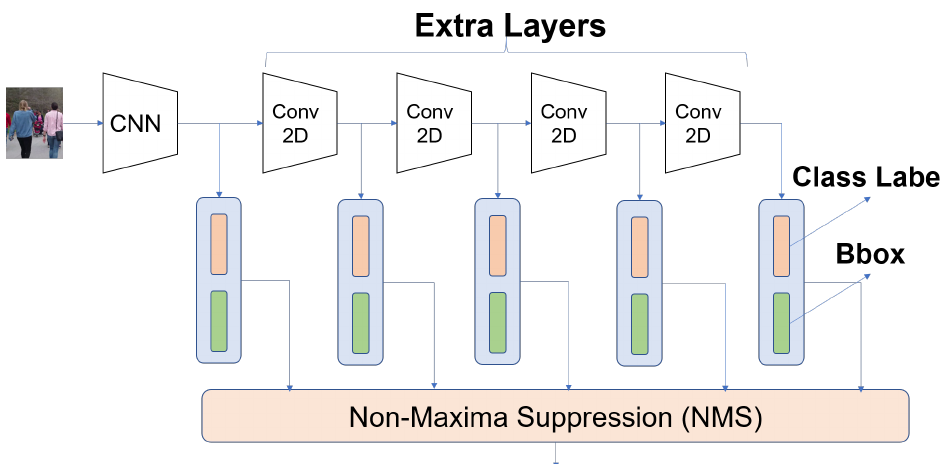
Figure 4. SSD Architecture [29] for Object Detection, which consists of a CNN backbone followed by extra convolutional layers. Classification and Regression Layers follow, and the last step is NMS, which removes redundant detections based on spatial